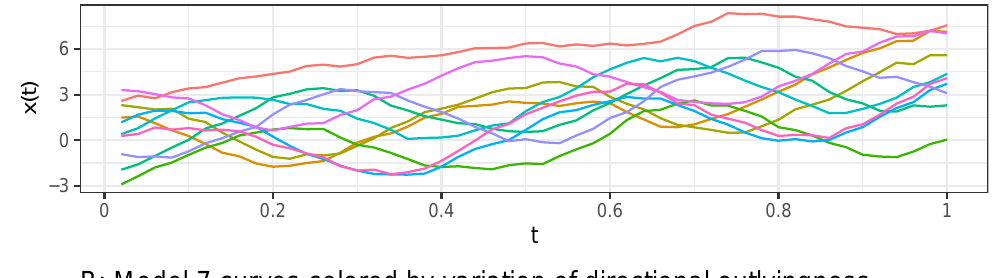
B: Model 7 curves colored by variation of directional outlyingness